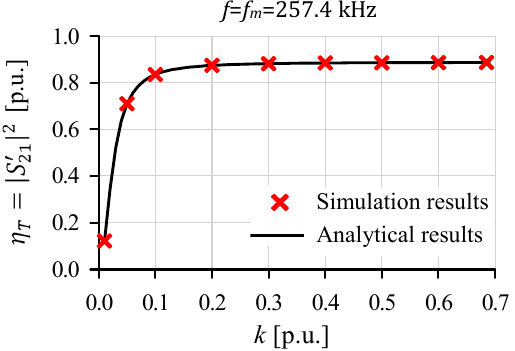
Figure 7. Power transfer efficiency of the matched asymmetric wireless power transmission system versus the coupling coefficient ( k ).